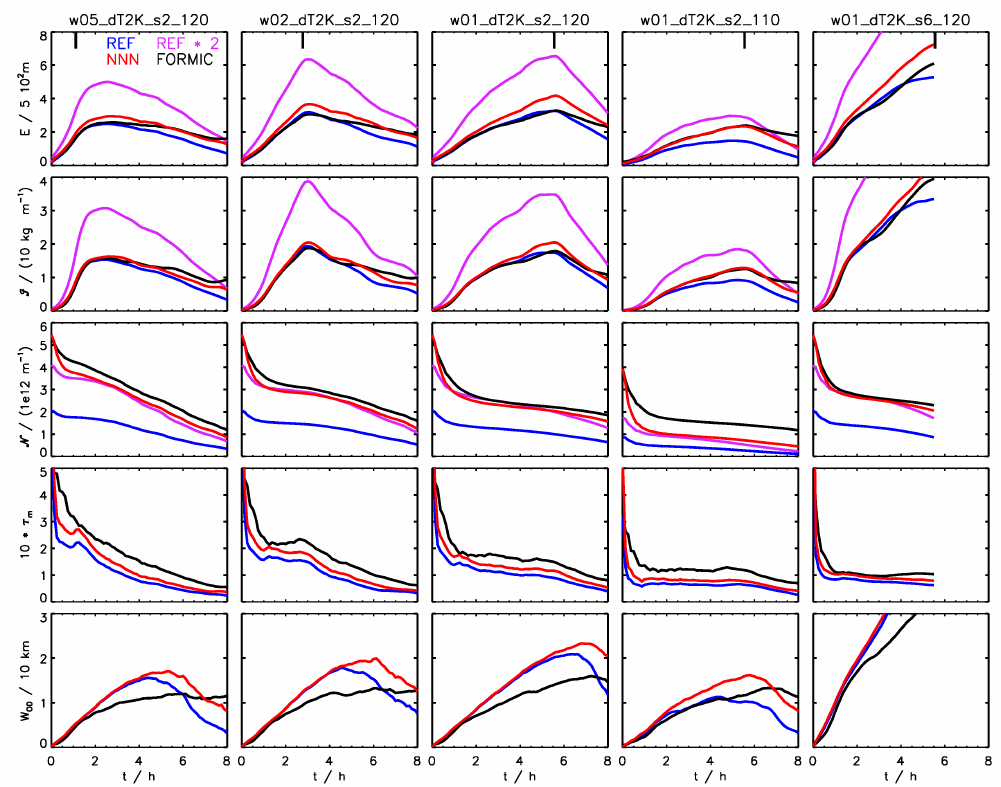
Figure 5. Temporal evolution of various contrail-cirrus properties are displayed for a selected set of simulation setups: total extinction E , total ice crystal mass I and number N , optical thickness τ m , and width W OD (from top to bottom). The synoptic scenario is given on top of each panel. In this figure, ∆ T = 2K scenarios with no surrounding natural cirrus are displayed. The black bar indicates the time the synoptic scale updraught